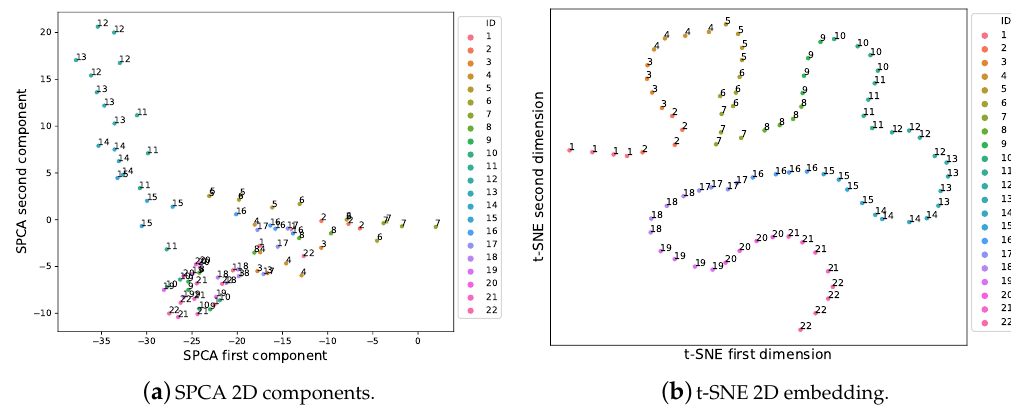
Figure 4. On the left, the visualization of the first two components of the sparse principal component analysis (SPCA) projected data. On the right, 2D t-Distributed Stochastic Neighbor Embedding (t-SNE) projection of the D matrix after applying the SPCA on the data extracted by the first dataset. The ID number on each projected point distinguishes the subjects present in the dataset.